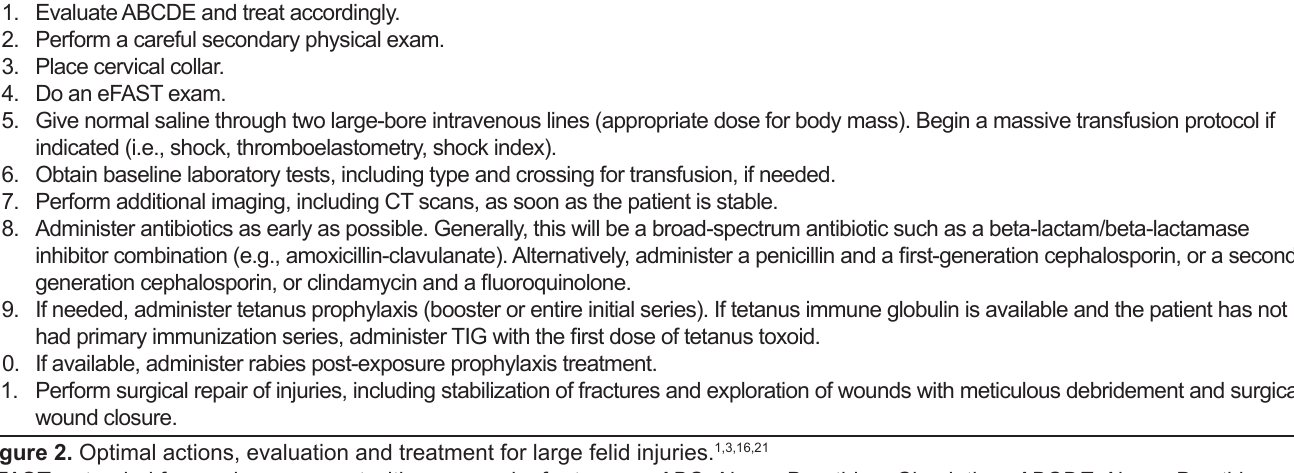
Figure 2. Optimal actions, evaluation and treatment for large felid injuries. 1,3,16,21 eFAST , extended focused assessment with sonography for trauma; ABC; Airway,Breathing, Circulation; ABCDE , Airway, Breathing, Circulation, Disability, Exposure; CT , computed tomography; TIG , tetanus immune